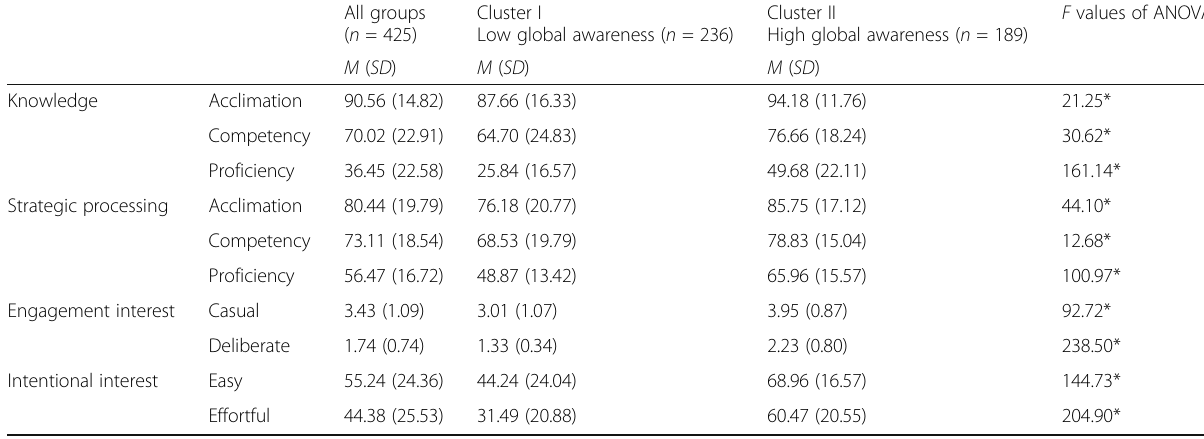
Table 6 Means and standard deviations for knowledge, strategic processing, and interest for the low and high global awareness clusters